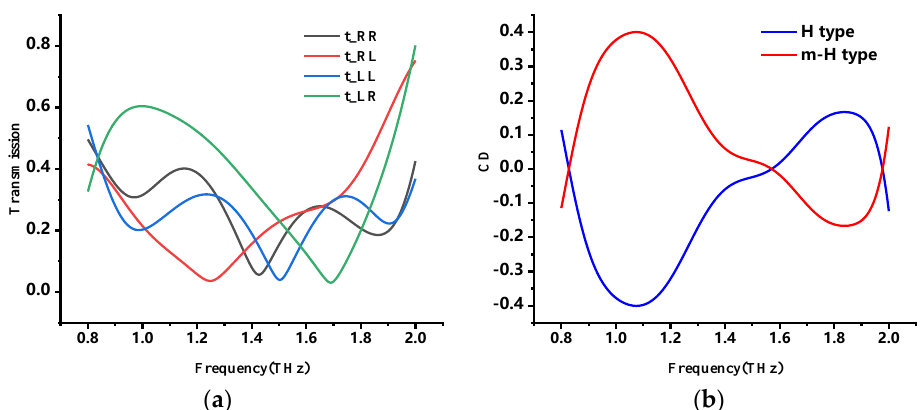
Figure 5. ( a ) Circular polarization transmission coefficient of H-type structure. ( b ) CD spectra of H type and m-H type.